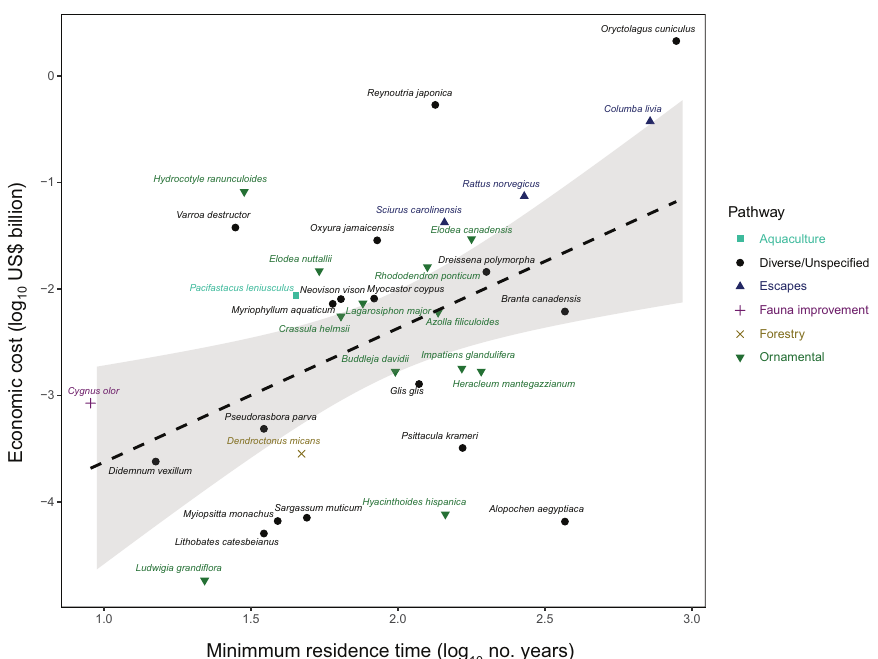
Figure 6. Invasion costs (US$ billions) as a function of number of years since introduction for UK invasive species. Note that both the x - and y -axes are on a log regression model fit and the shaded area the 95% confidence interval. Pathways of introduction per spe- cies are indicated by different fill shapes and